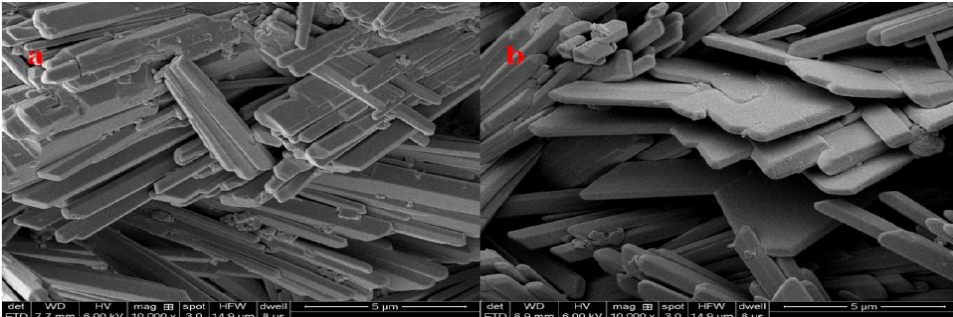
Figure 9. SEM images of the hardened gypsum. ( a ) Blank; ( b ) with PCE-1.